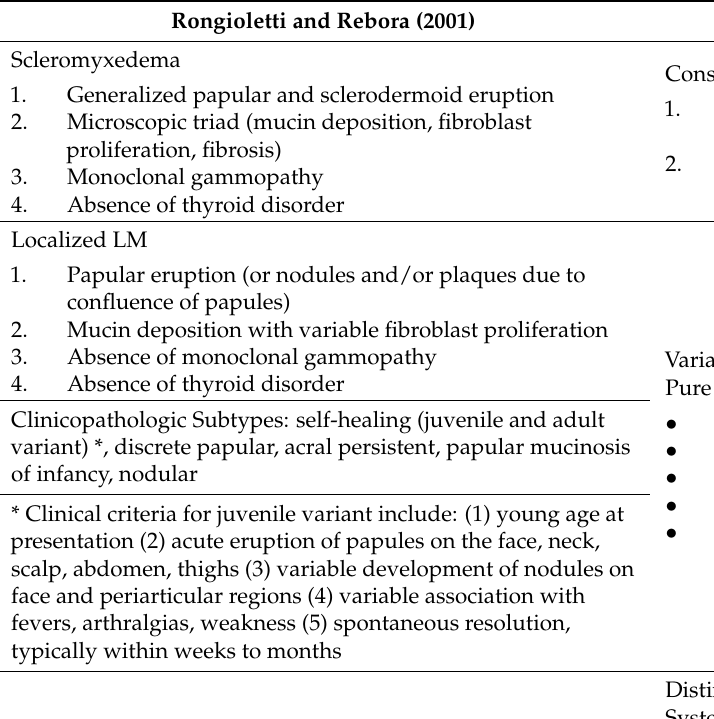
Table 1. A comparison of the 2001 lichen myxedematosus diagnostic criteria proposed by Rongioletti and Rebora and the updated 2017 diagnostic criteria proposed by Nofal et